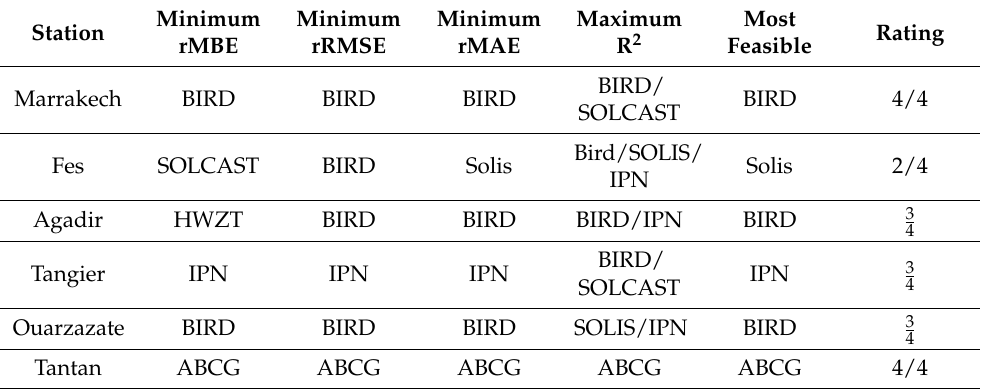
Table 6. Best-performing clear sky models per hourly statistical metrices, most feasible model, and rank of performance